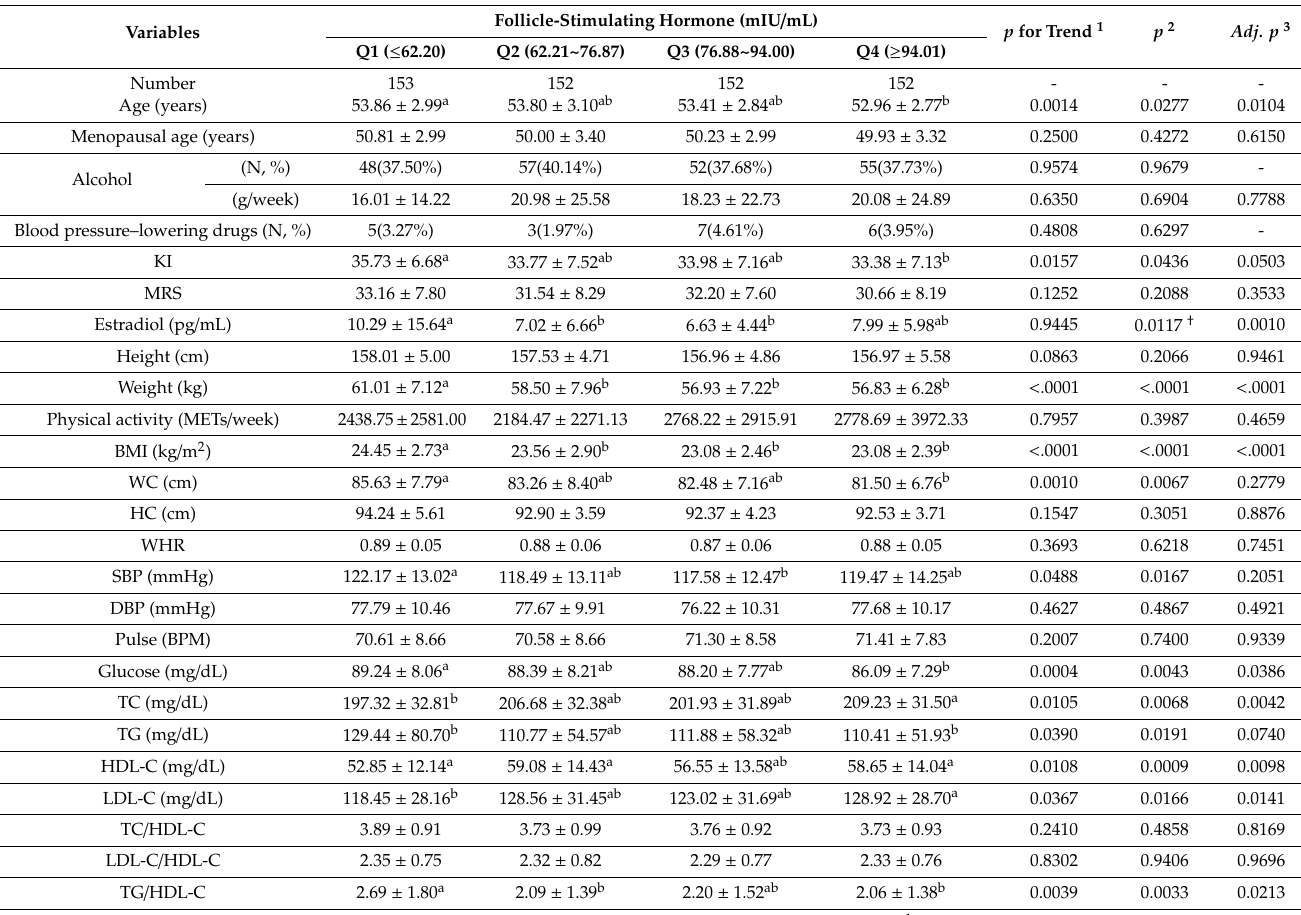
Table 1. General characteristics and cardiometabolic risk factors of study participants by quartiles of follicle-stimulating hormone